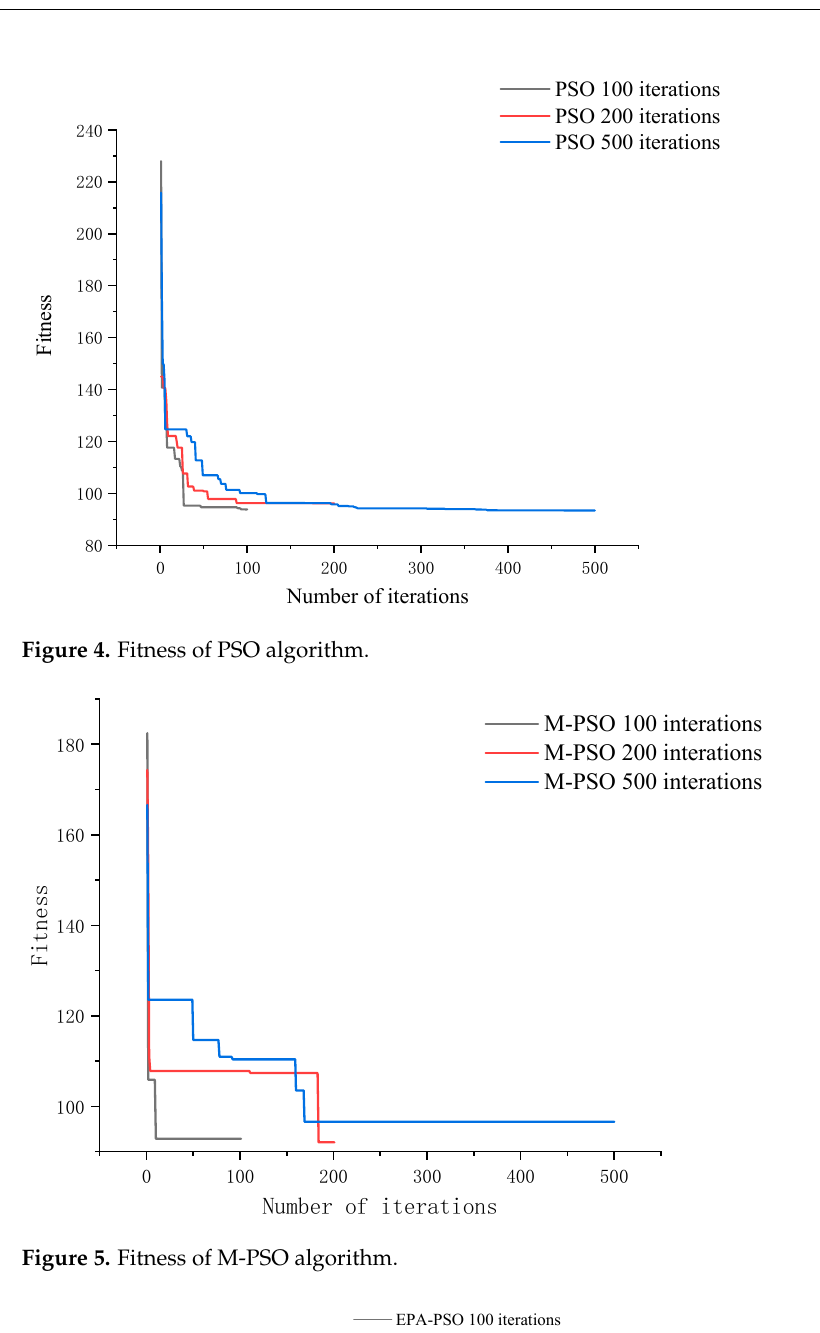
Figure 5. Fitness of M-PSO algorithm.